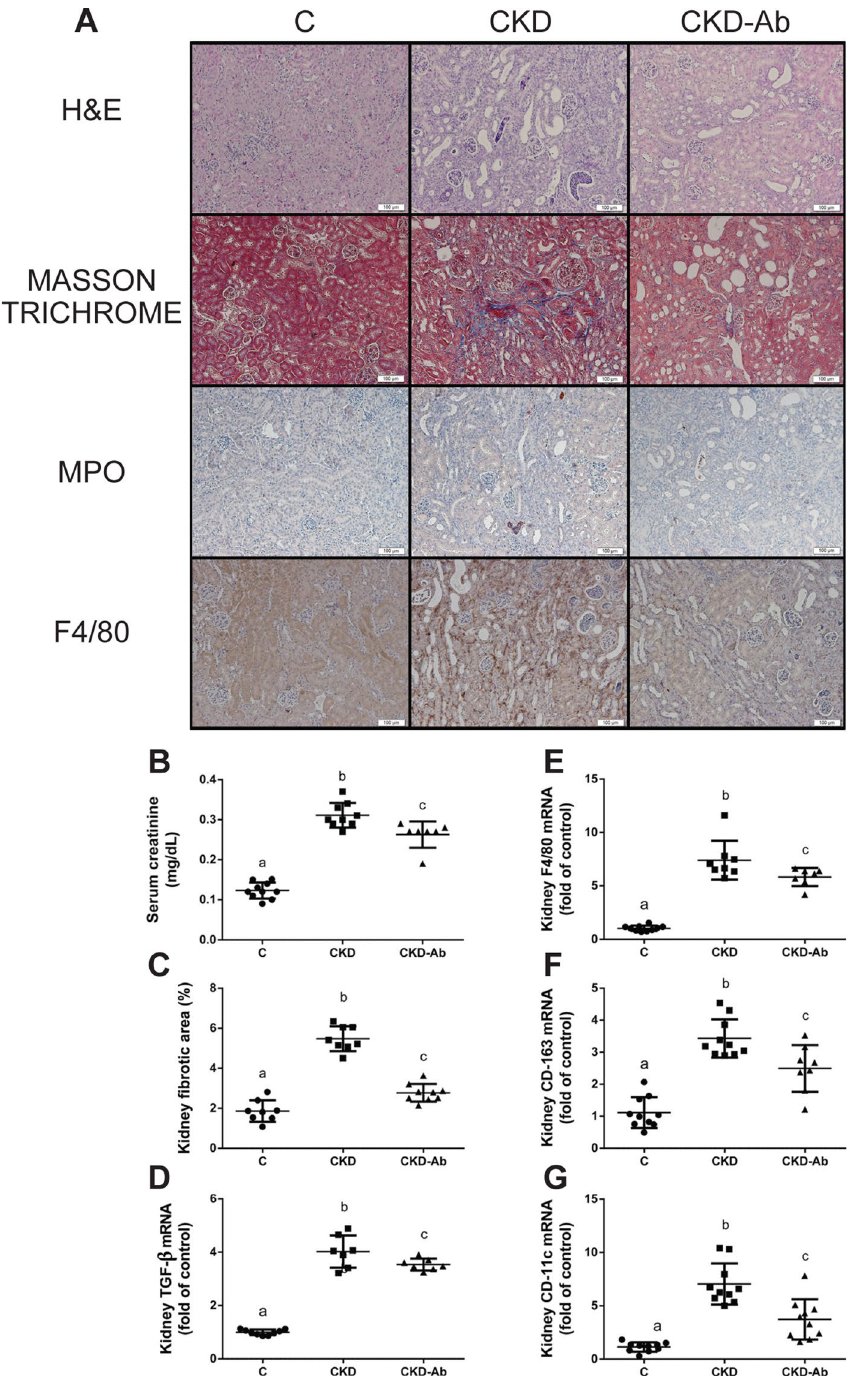
Figure 6. Renal changes in CKD mice following IL1 inhibition. Experimental groups included mice on regular (C) or adenine diet, injected with saline (CKD) or an anti-IL1 monoclonal antibody (CKD-Ab). Representative kidney sections (A) , Upper 2 rows: kidney sections stained with hematoxylin & eosin and Masson Trichrome. Lower 2 rows: immunohistochemical staining for neutrophils (Myeloperoxidase—MPO) and macrophages (F4/80). Bar = 100 μm. Serum creatinine (mg/dL) (B) . Kidney fibrotic area percentage as determined by the extent of Masson Trichome staining, analyzed with the ImageJ software (C) . Kidney TGF-β (D) , F4/80 (E), CD-163 (F) and CD-11c (G) mRNA levels. n = 6–10 animals per group. Different letters above bars indicate a significant difference between groups, similar letters indicate no significant